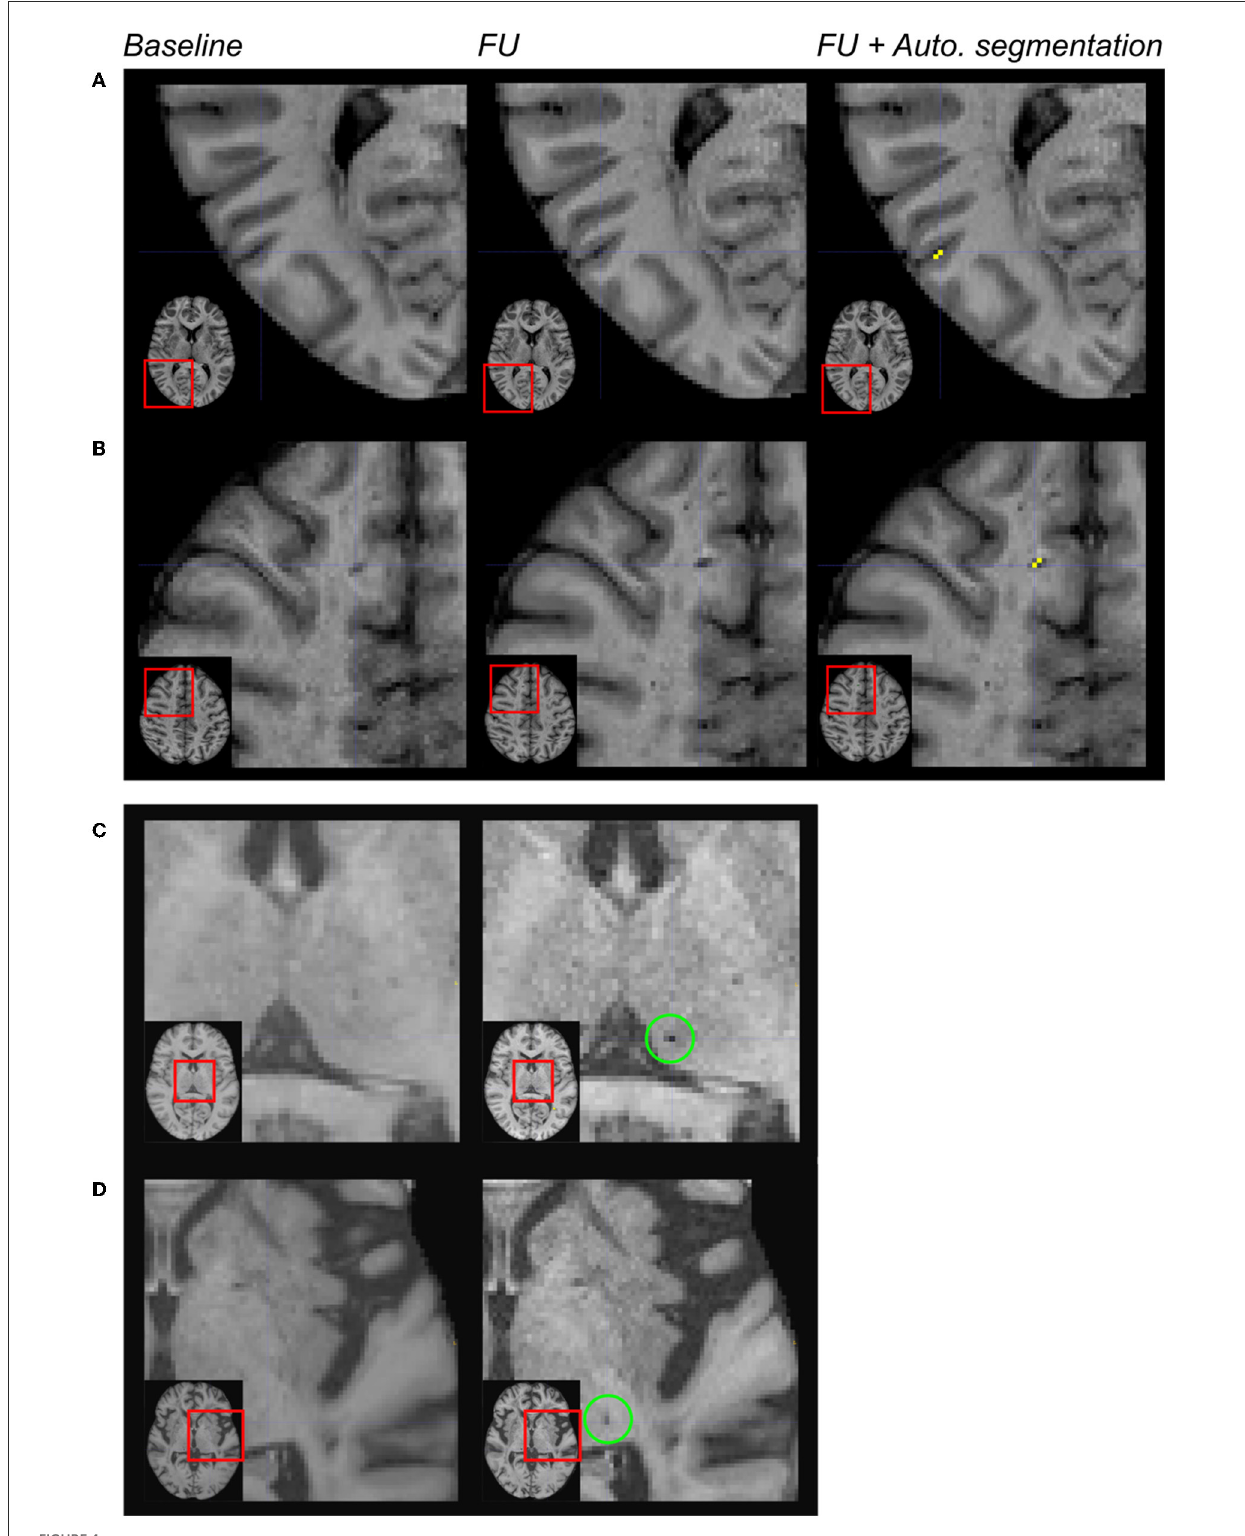
FIGURE4 Limitations of the automated segmentation. From left to right: magnification of MR images in different patients after the registration of the baseline and follow-up (FU) data in the MNI space. In the right column, the automated segmentation of lesions was superimposed on the FU MRI. Because of brain atrophy in patients with CADASIL, false positive lacunes were identified by the algorithm after the enlargement of some cortical sulci (A) . Because the CSF signal has changed across acquisitions within perivascular spaces, false positive incident lacunes were also detected at such locations (B) . The algorithm failed because of the size of the cluster of interest (diameter < 3mm) (C) . The algorithm failed because the region of interest did not belong to the CSF mask of follow-up data (D)